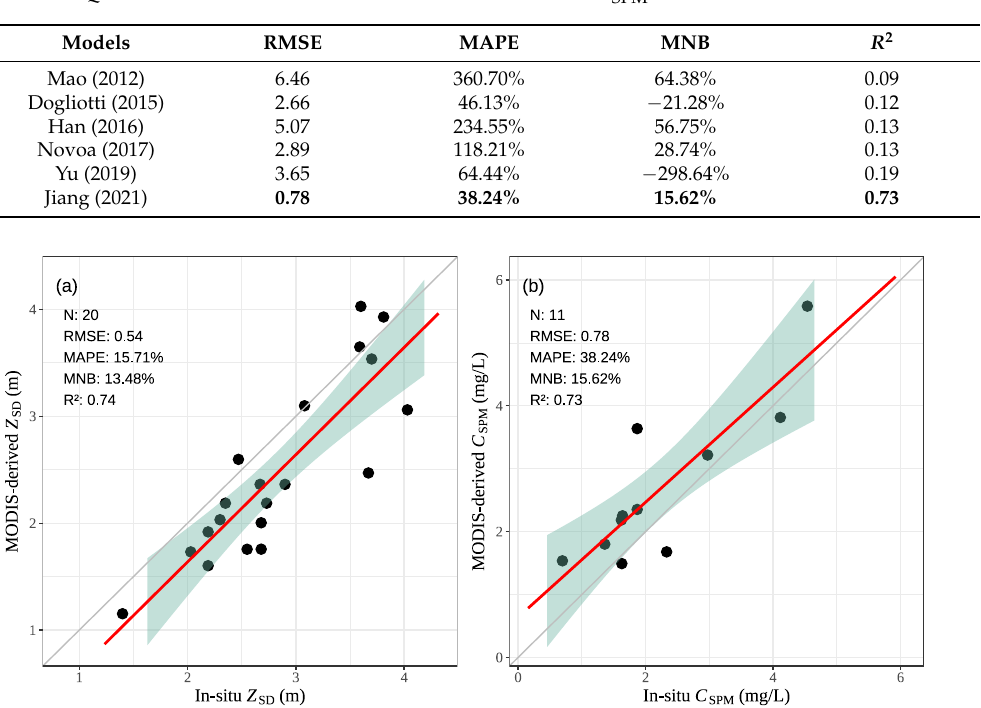
Table 3. Quantitative evaluation of the inversion models for C SPM .